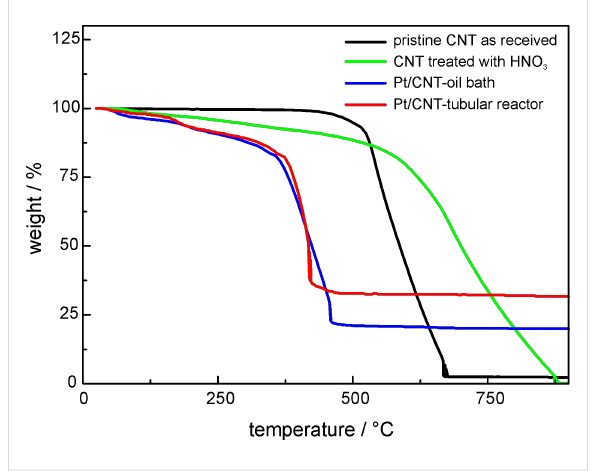
Figure 3: TGA weight loss curves for pristine CNT, HNO 3 oxidized CNT, Pt/CNT-oil bath and Pt/CNT-tubular reactor